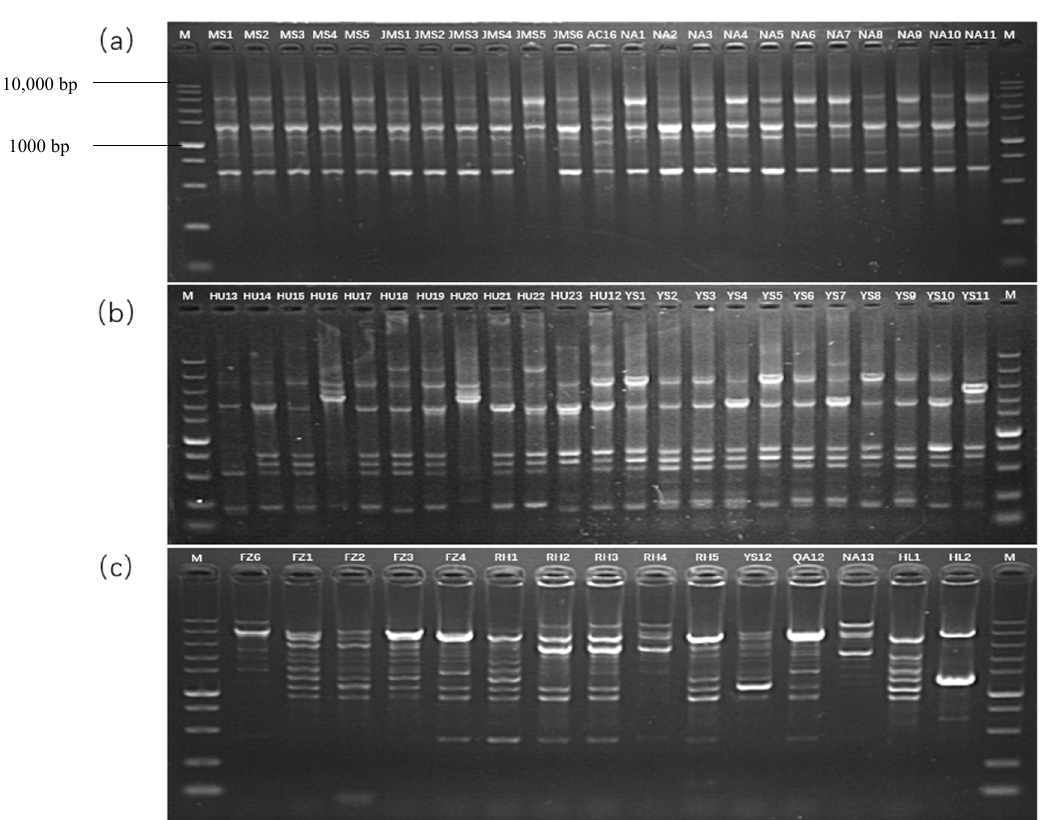
Figure 4. Genomic fingerprints of P. s. pv. syringae isolates generated by BOX ( a ), ERIC ( b ), and REP ( c ) primers in 2% agarose gel.